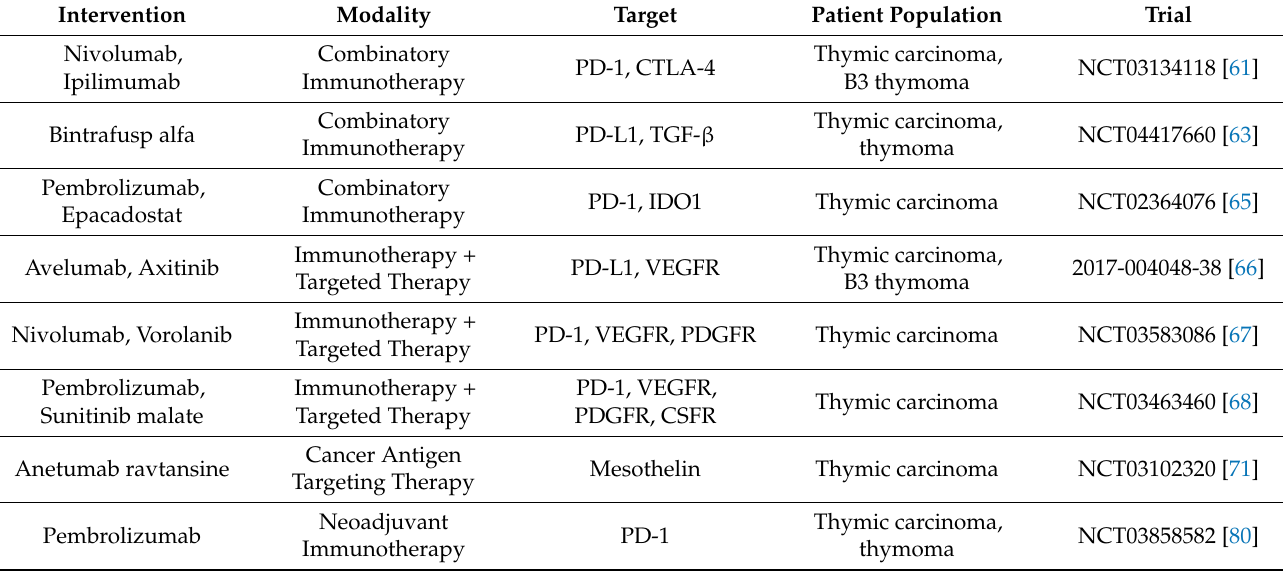
Table 3. Ongoing clinical trials of novel immunotherapeutic modalities in patients with thymic epithelial